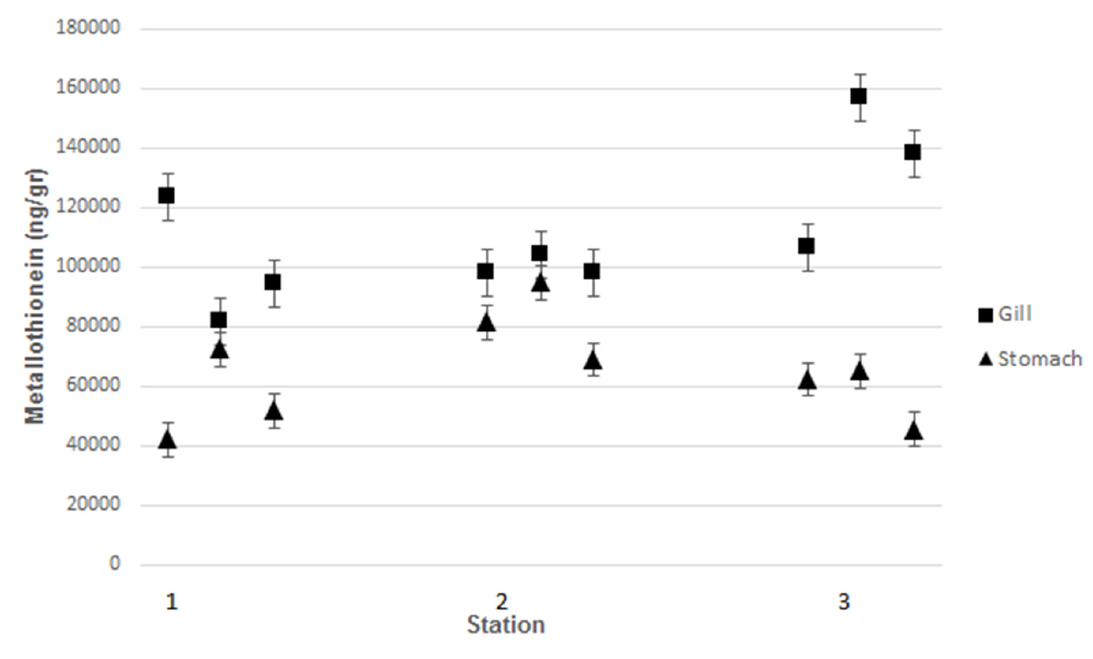
Figure 4. Metallothionein level (wet mass) in the gills and stomach of Crassostrea glomereta collected from the three stations. Station 1, Mayangan; Station 2, Kenjeran; Station 3, Gresik port.